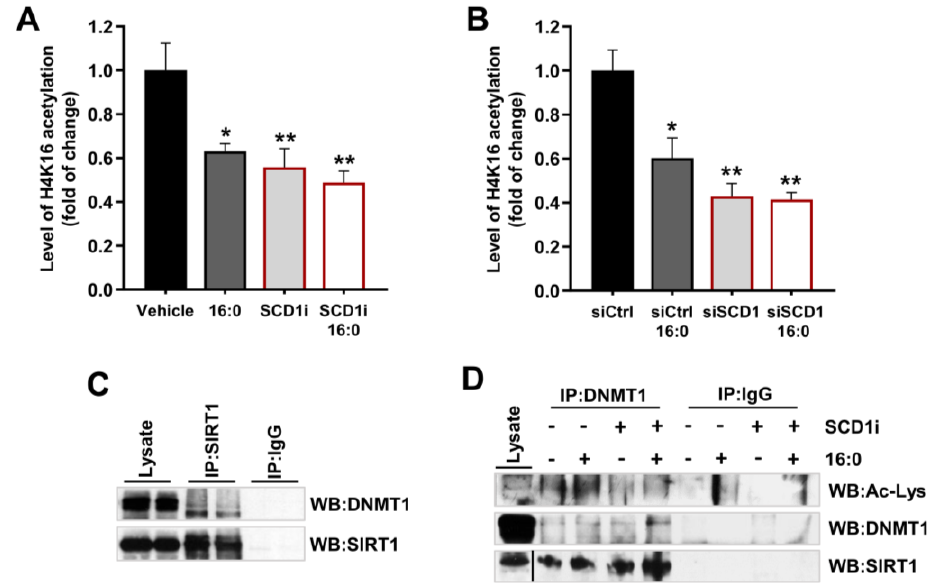
Figure 5. Downregulation of SCD1 elevates SIRT1 activity in INS-1E cells and promotes the deacetylation of DNMT1 by SIRT1. ( A , B ) Global acetyl histone H4K16 levels in INS-1E cells (indirect indicator of SIRT1 deacetylase activity) after the pharmacological inhibition of SCD1 (SCD1i) ( A ) or silencing of SCD1 gene expression ( B ) and palmitate (16:0) treatment. The data are expressed as the mean ± SD of three independent experiments. * p < 0.05, ** p < 0.005, vs. vehicle/siCtrl. ( C ) Mock precipitates (IgG control) and anti-SIRT1 immunoprecipitates from whole INS-1E cell lysates that were analyzed by Western blot using an antibody against DNMT1. ( D ) Control and anti-DNMT1 immunoprecipitates from INS-1E cells that were treated with the SCD1 inhibitor A929371 (SCD1i) and palmitate (16:0) and immunoblotted with SIRT1 and anti-acetylated lysine (Ac-Lys) antibody.